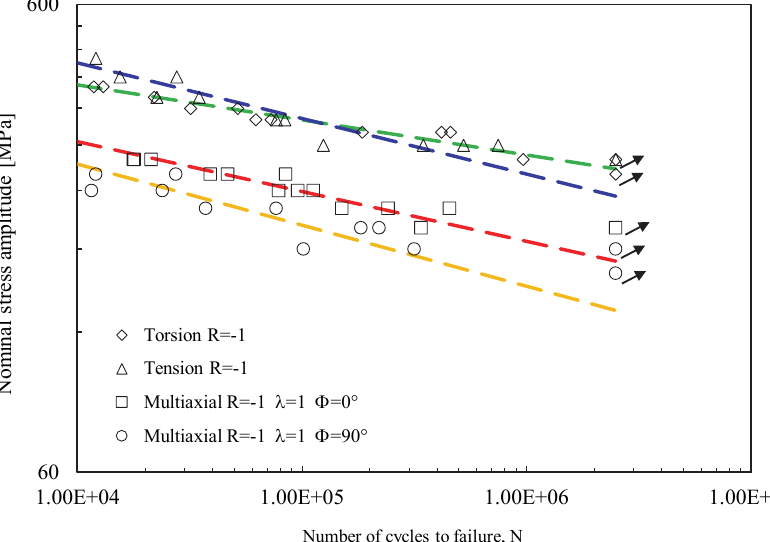
Figure 3: Data from multiaxial tests from V-notched specimens.